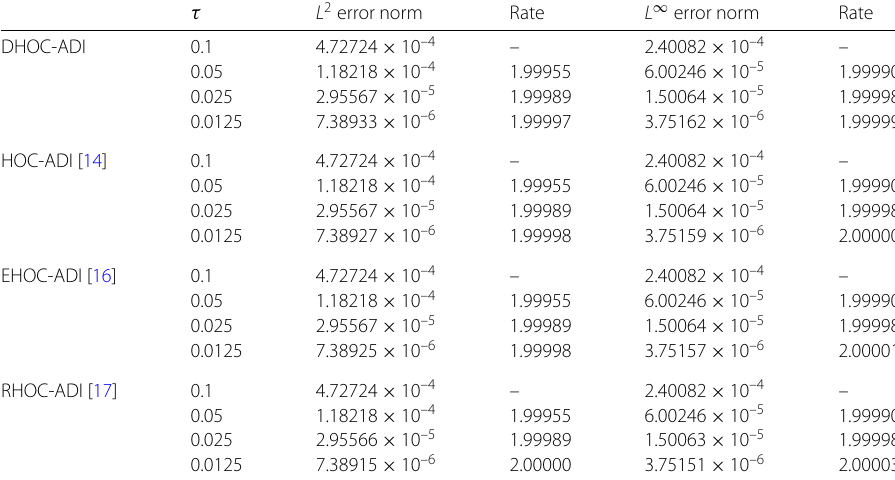
Table 2 The error norms of numerical solutions and the rate of convergence in time where h =